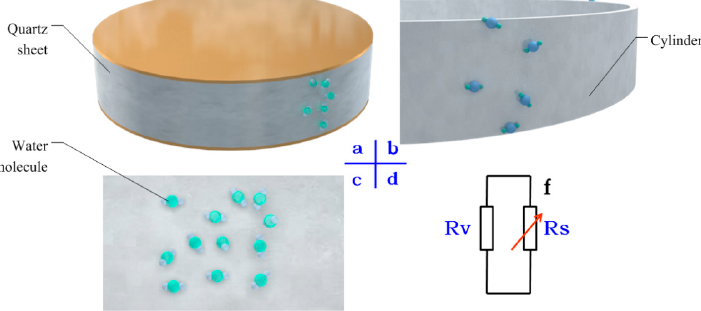
Figure 3. Piezoelectric dynamometers and interactions of water. ( a ) Sheets and water molecules; ( b ) Cylinder and water molecules; ( c ) Flat surface and water molecules; ( d ) The sheet resistance and bulk resistance.